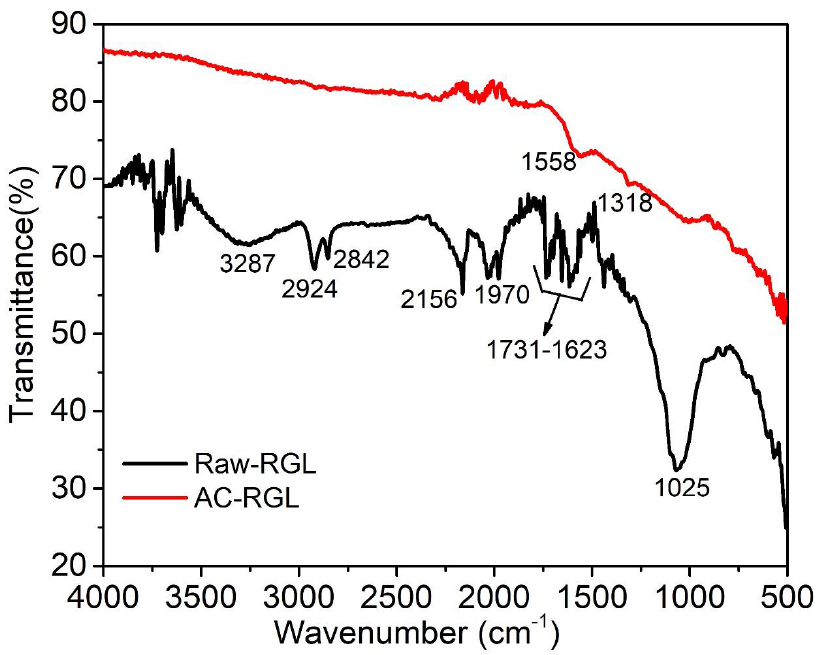
Figure 4. FTIR spectra of Raw-RGL and AC-RGL